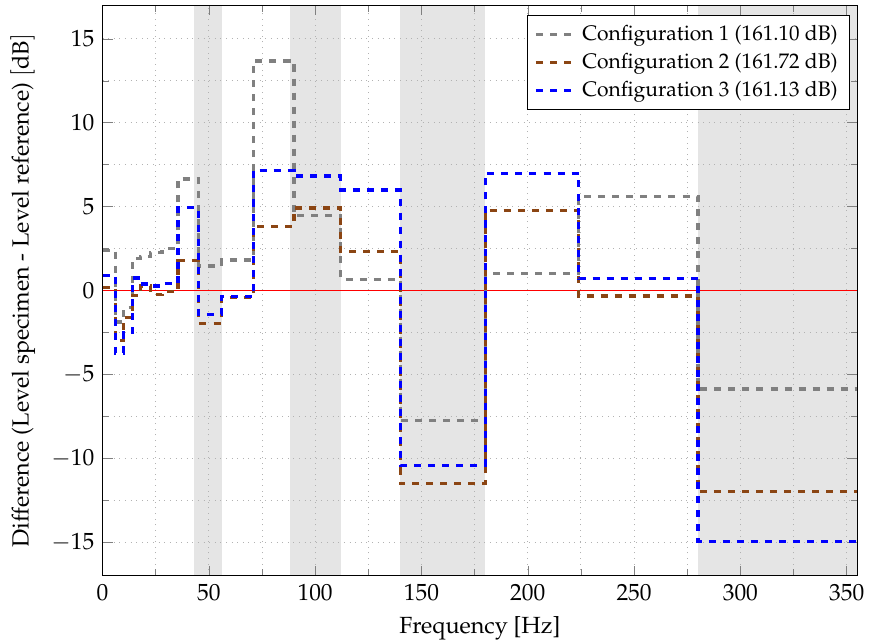
Figure A14. Difference in One-third octave band representation of FRF of WTS test specimen for three different configurations. SL value of surface velocity is given in dB.